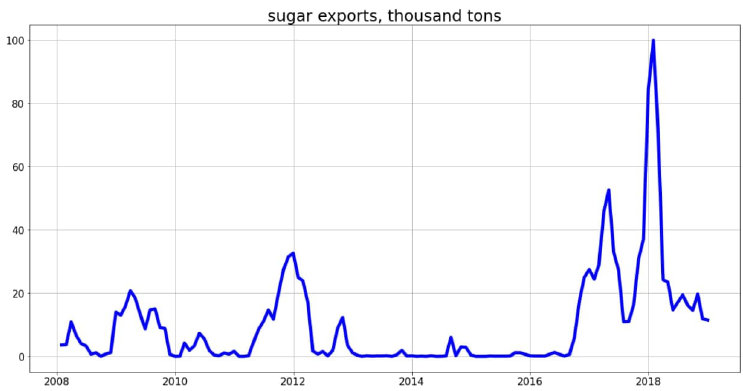
Figure 17. Export of sugar from Russia.